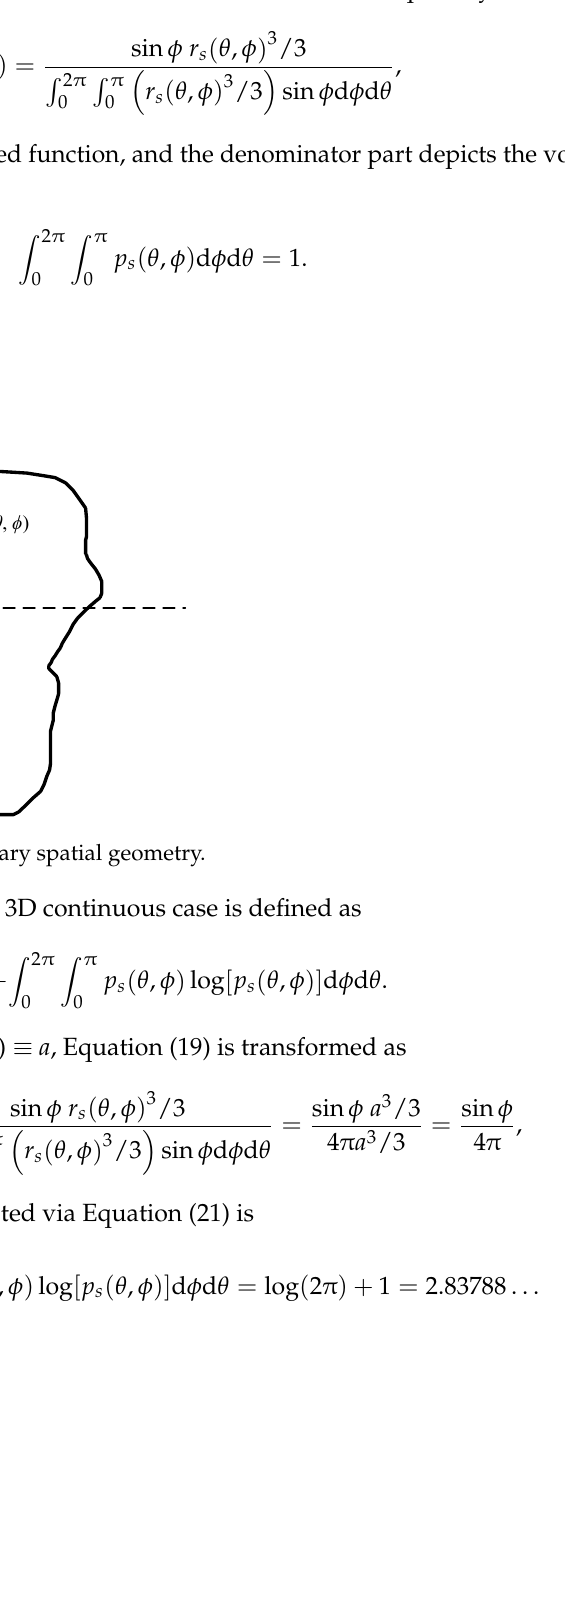
Figure 4. The shape entropies of non-convex shapes are shown in Figure 3, provided that b = 1, a = 1, 1.5,